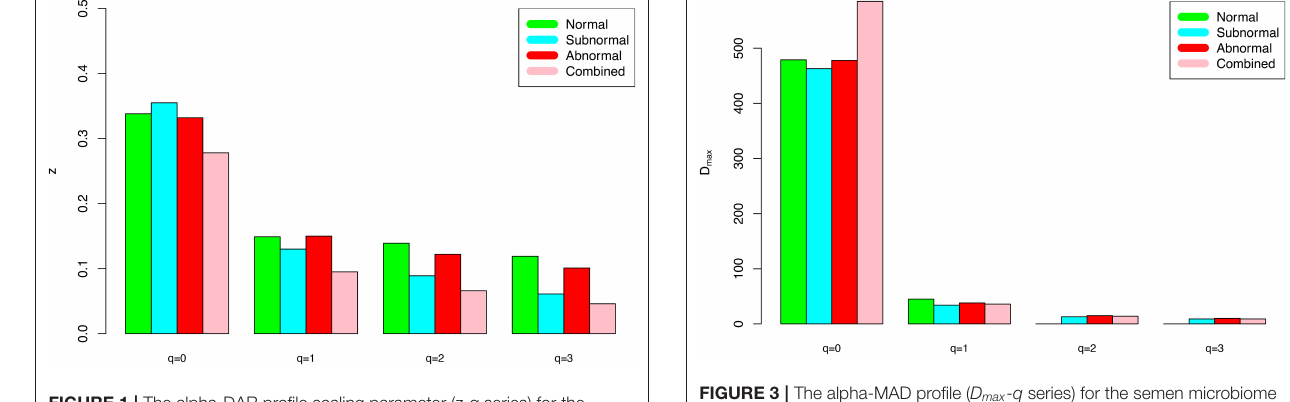
FIGURE 1 | The alpha-DAR profile scaling parameter ( z-q series) for the semen microbiome alpha-diversity at the genus level, for normal, sub-normal, abnormal, and combined groups.